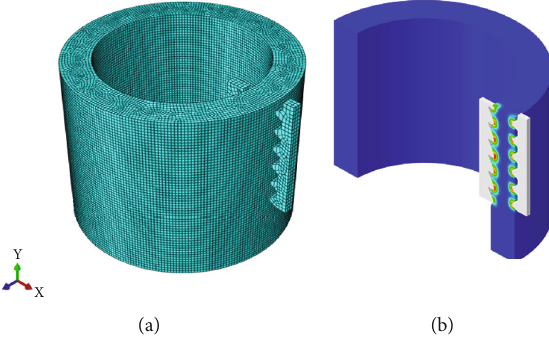
Figure 5: FEA simulation for crimping process: (a) meshing; (b) result data